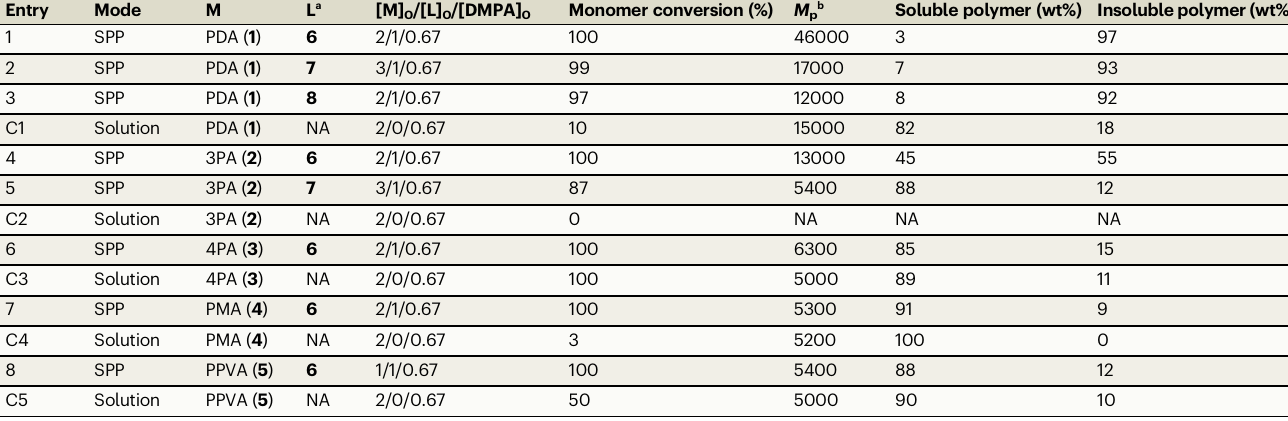
Bold values indicate the numbering ofthemonomers and linkersusedinthe solid-phasepolymerization. DMFwas usedas theGPCeluent. M p isthepeak-topmolecularweight.Becauseofthepresence ofoligomersandpossibleclustersofLiBrcontainedin theDMFeluent,theGPCbaselinewasnot horizontal in all cases.Hence, thenumber-averagemolecular weight ( M n ) anddispersity ( Đ ) values werenot accurately determined,andwestudied the M p value instead. a L=XB